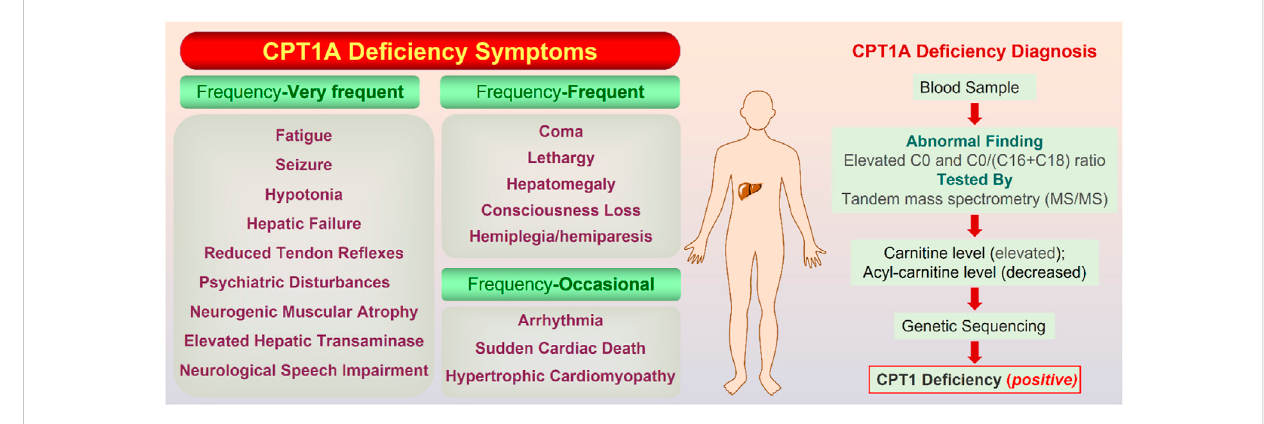
FIGURE 7 On the left are the symptoms of CPT1A de fi ciency gathered from Genetic and Rare Diseases (GARD) Information Center (https://rarediseases.info. nih.gov/).Ontherightisthecon fi rmatoryscreeningprocessforCPT1Ade fi ciencydiagnosis.ThenormalvalueoftheC0/(C16+C18)ratiois278.75;Total carnitine is normal at 33 – 70 mmol/L and free carnitine is normal at 28 – 52 mmol/L (Dowsett et al., 2017).